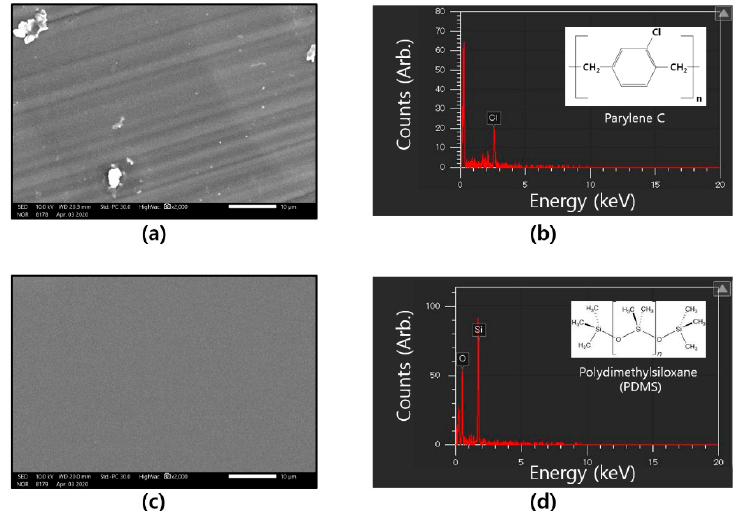
Figure A4. Scanning electron microscope (SEM) images and energy-dispersive X-ray spectroscopy data of Parylene C and PDMS films: ( a ) SEM image of chemical vapor deposited Parylene C film; ( b ) EDS data of the surface of Parylene C film; ( c ) SEM image of spin-casted PDMS film; ( d ) EDS data of the surface of PDMS film.